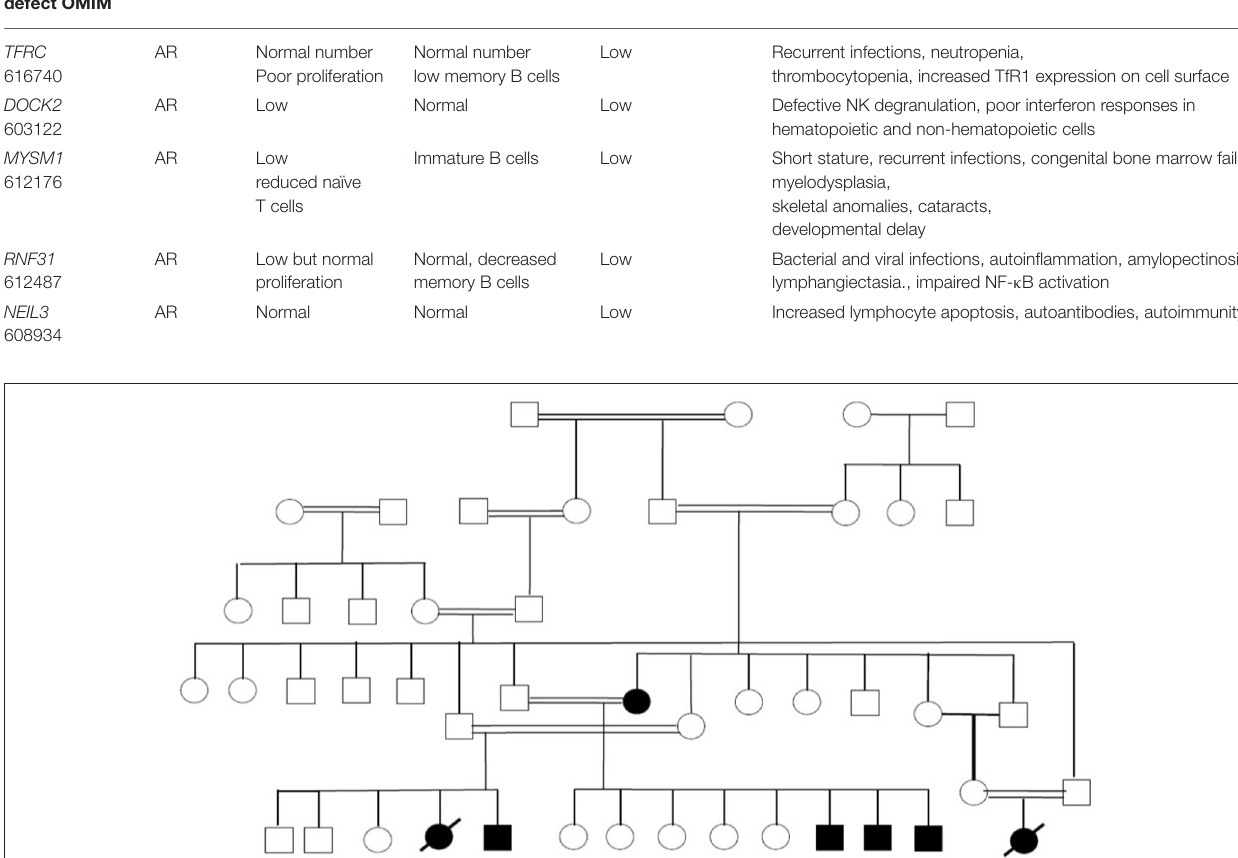
TABLE 2 | Clinical and immunologic phenotype of patients with novel PID-causing genes. Genetic defect OMIM